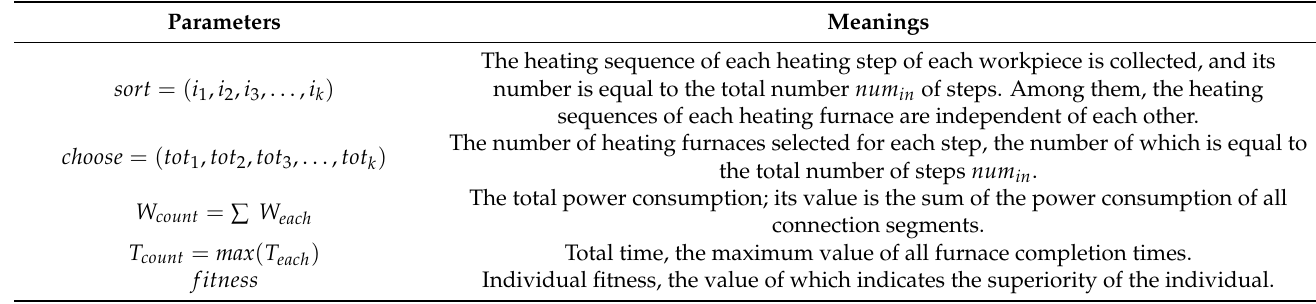
Table 3. Objective function